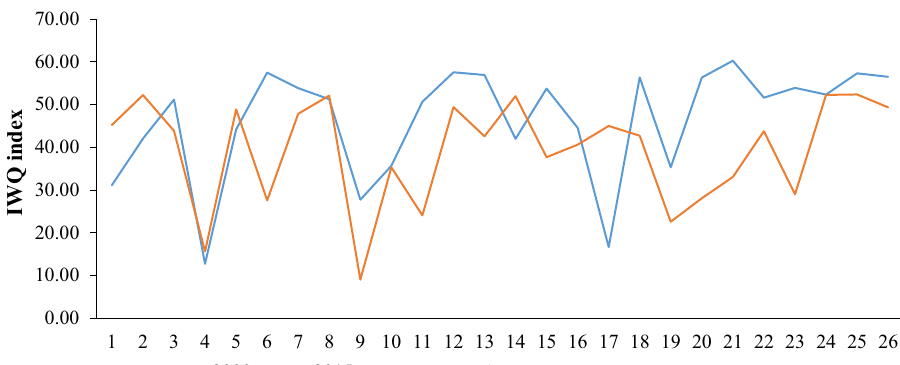
Fig. 9 Spatial distribution of IWQI (2000 and 2015) Fig. 10 Irrigation water quality index (2000 and